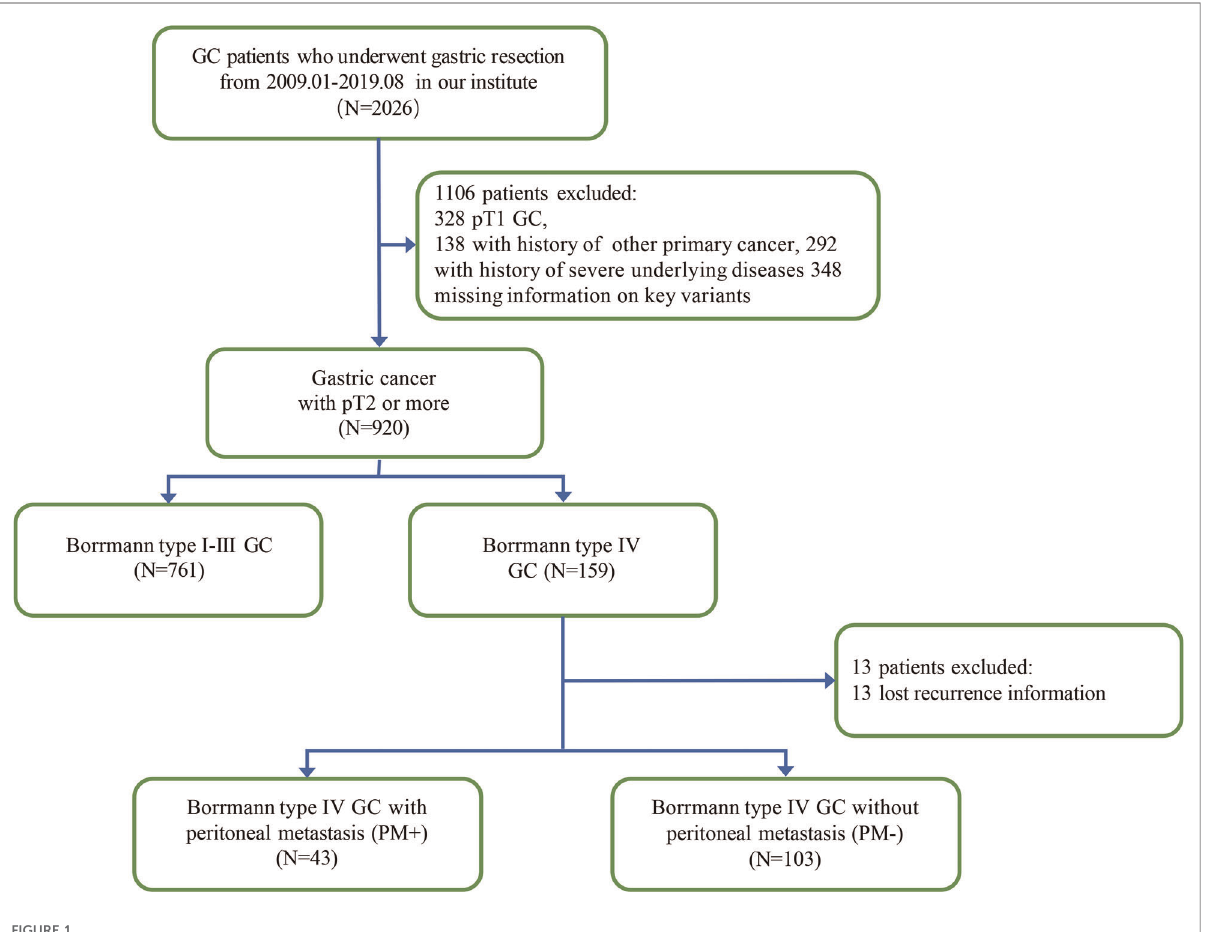
FIGURE 1 Study work fl ow diagram (GC, gastric cancer; PM, peritoneal